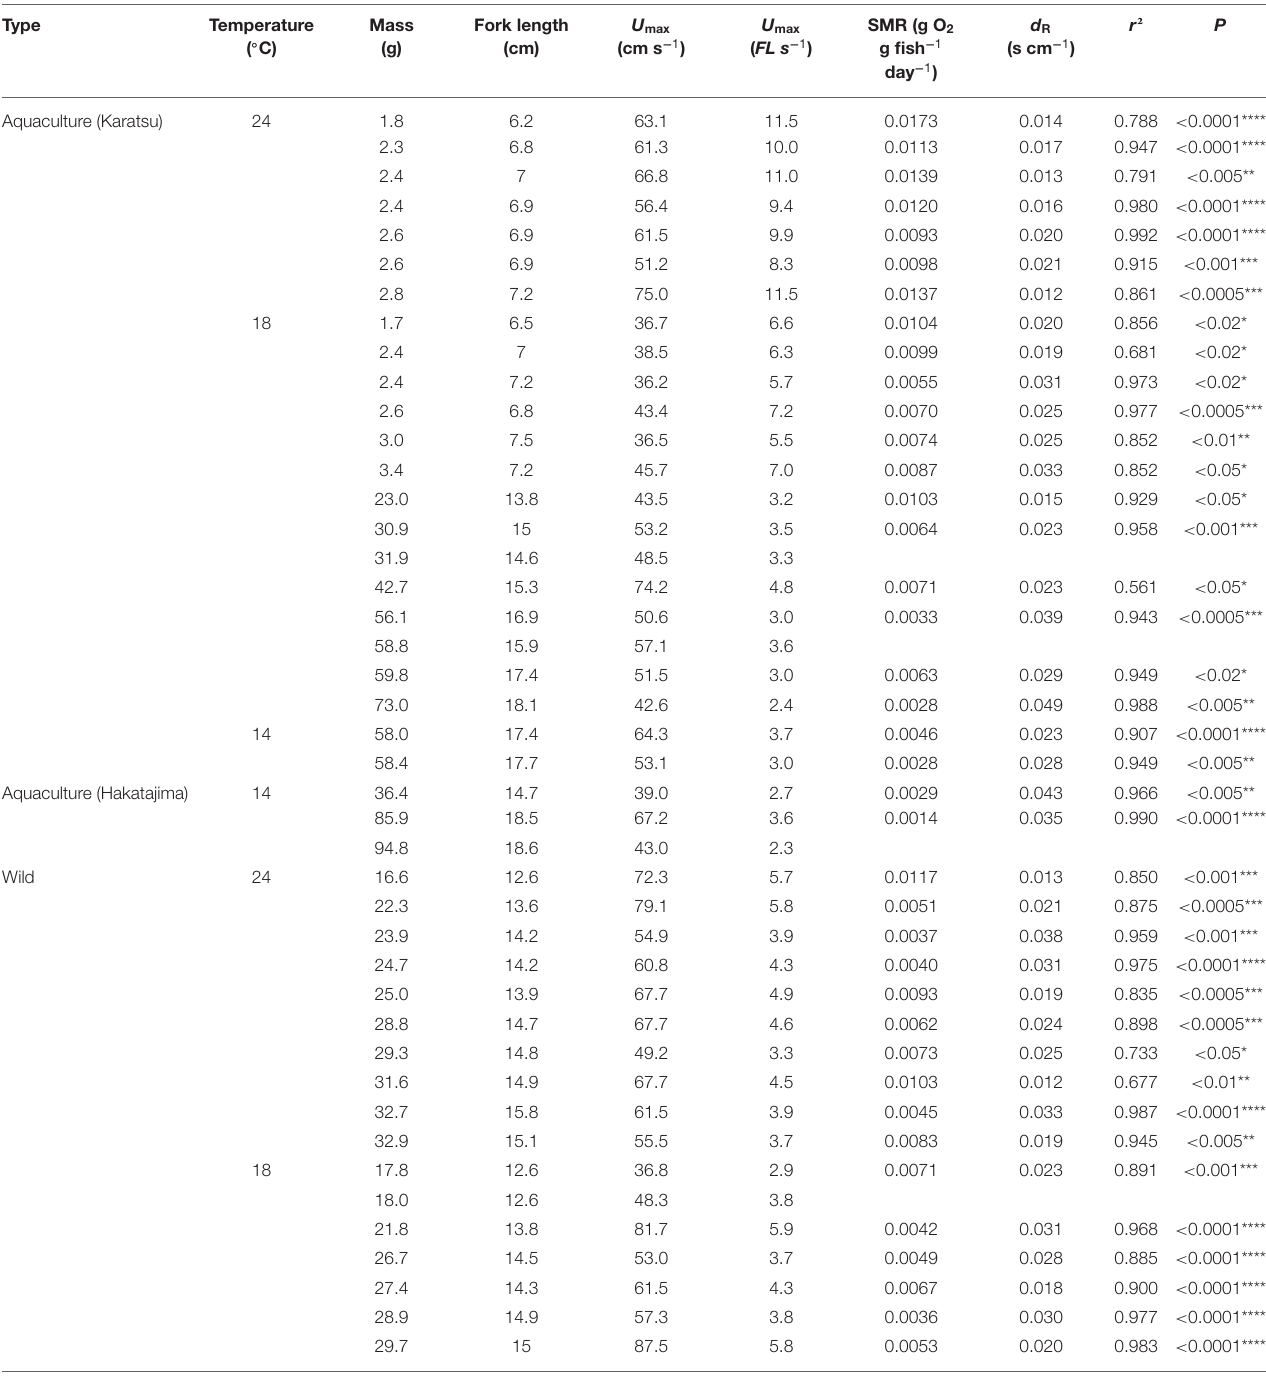
TABLE 1 | Source, size, and bioenergetics data for Northwestern stock Pacific chub mackerel individuals examined in the present study including collection location (source), experimental temperature ( ◦ C), fish mass ( W , g), fork length ( FL , cm), maximum sustainable swimming speed ( U max , cm s − 1 , and FL s − 1 ), and